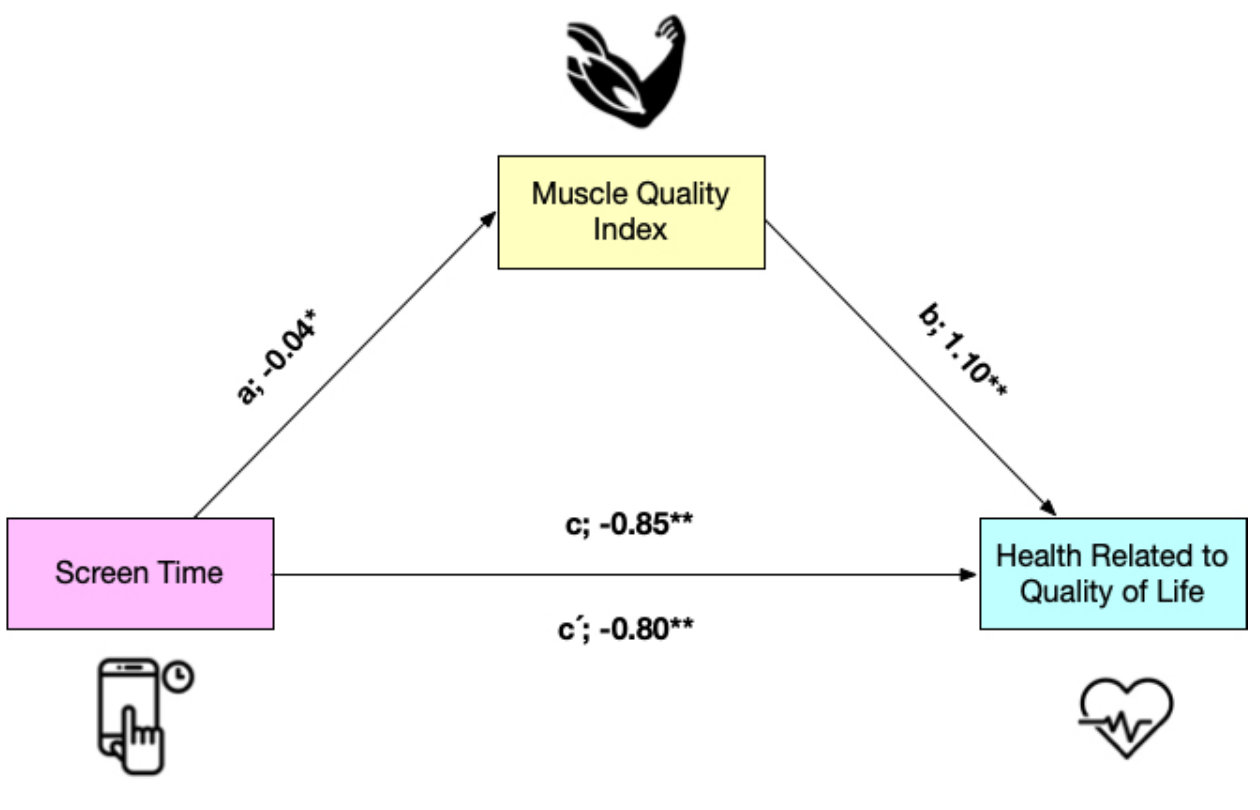
Figure 2. Mediation model testing whether the association between screen time and health related to quality of life was mediated by muscle quality index * p < 0.05; ** p < 0.001. Panel A non-adjusted, Panel B adjusted by sex and age.